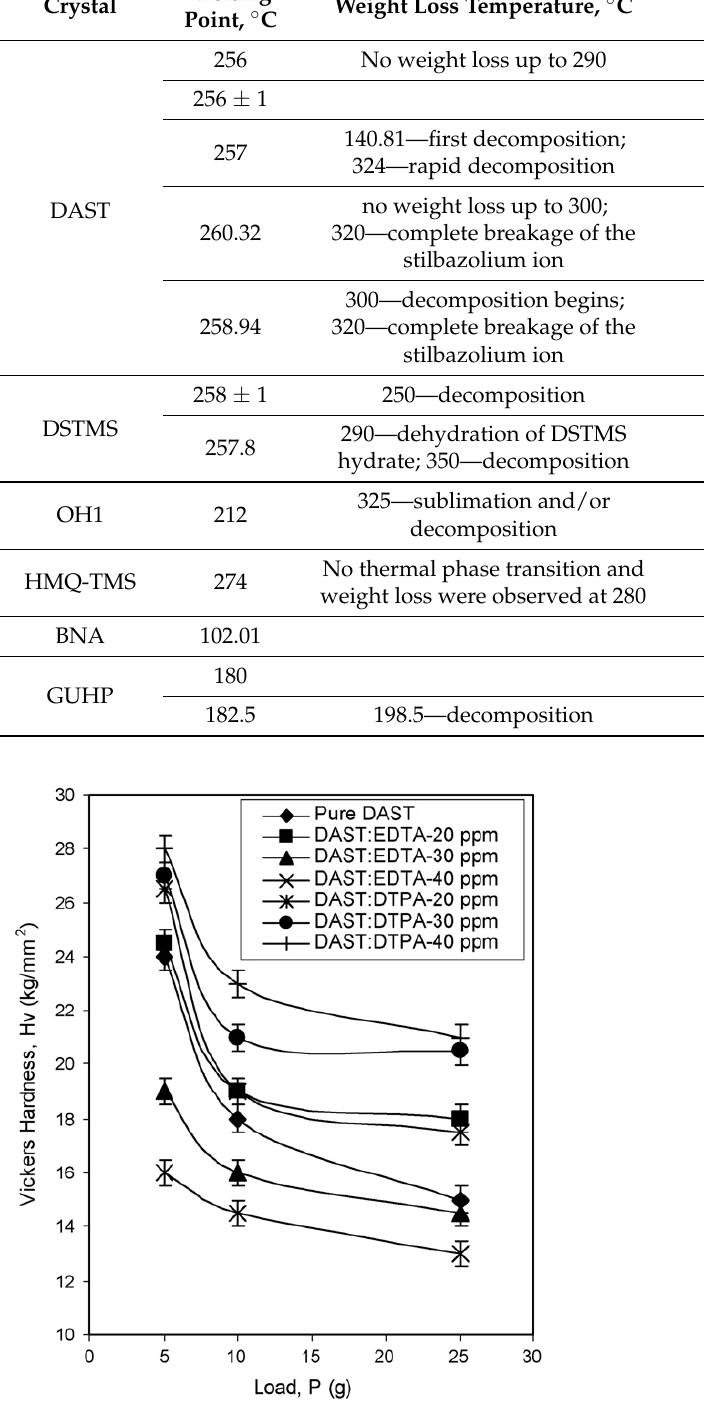
Figure 6. Variation of microhardness with the different loads for pure, DTPA, and EDTA-added DAST crystals. Reprinted from [189], with permission from